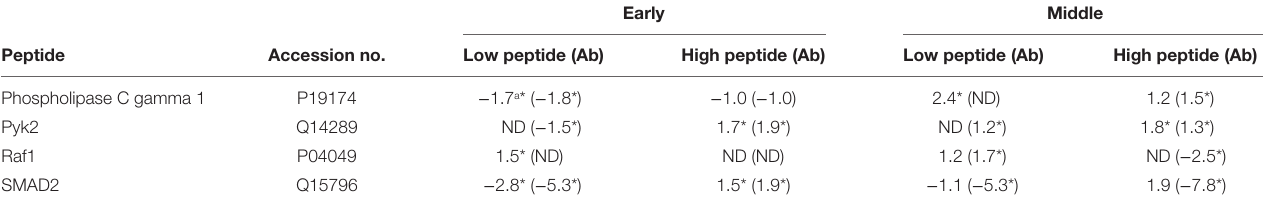
TaBle 6 | Fold-change in specific peptides associated with high and low loads of Salmonella Enteritidis using the peptide array and validation with the antibody array. early Middle Peptide accession